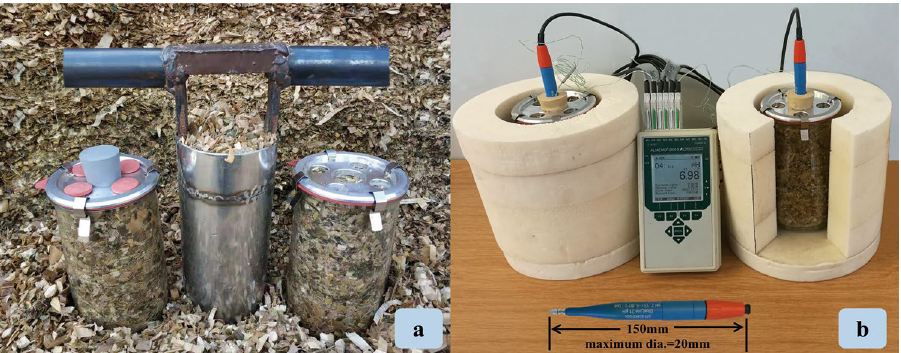
Figure 6. Silage probed using the core sampling device and immediately packed into jars in the on-farm silo ( a ), and the instrumented jars with insulating cover ready for laboratory incubation ( b